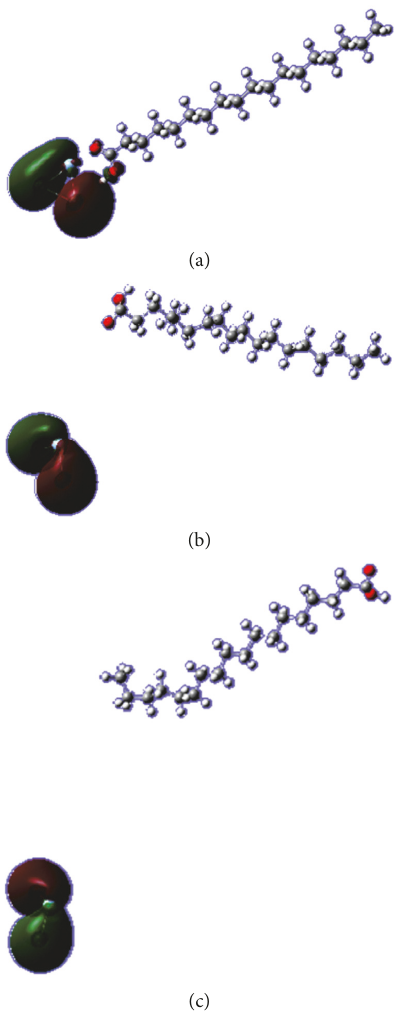
Figure 14: HOMO surfaces from molecular dynamics. Stearic acid with 3-atom silver cluster at (a) 0ps, (b) 5ps, and (c) 20